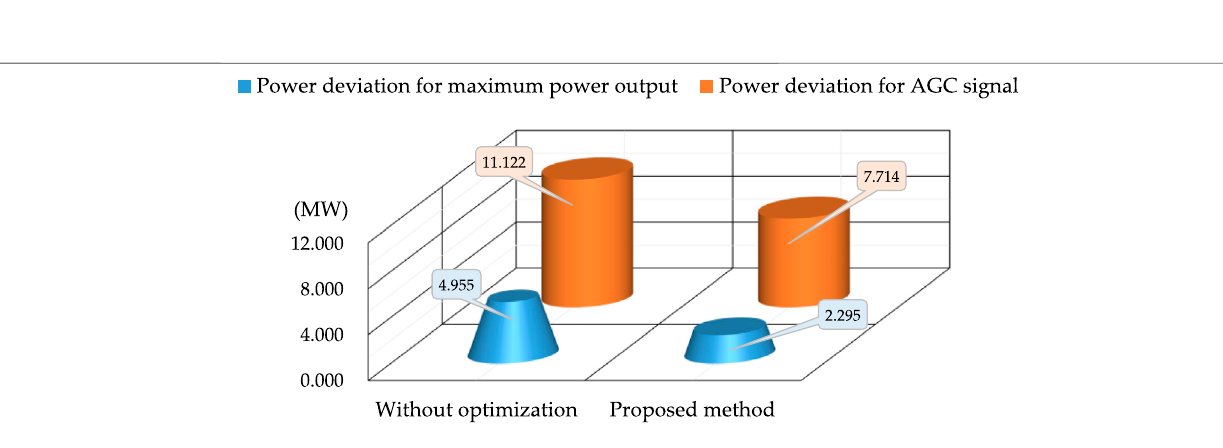
FIGURE 12 | Result comparison between proposed method and that without optimization on the varying AGC signals.